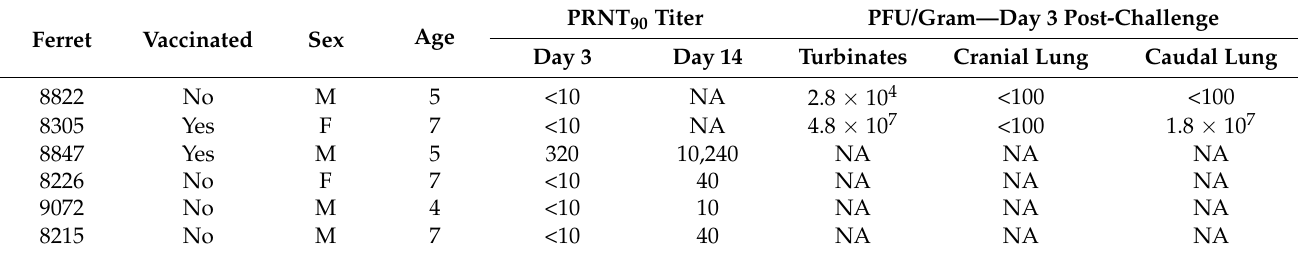
Table 3. Anti-SARS-CoV-2 plaque reduction neutralization titers (PRNT 90 ) in black footed ferrets challenged with SARS-CoV-2 (by vaccination status, sex, and age at challenge) and tissue burdens of virus at day 3 post-challenge in euthanized individuals in plaque-forming units